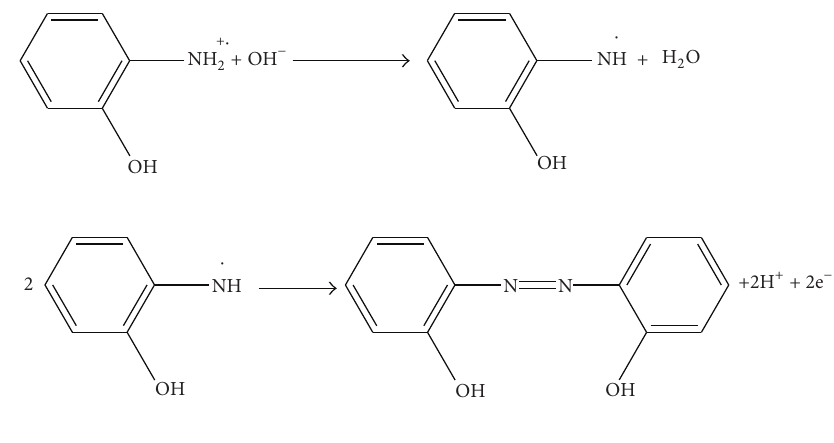
F 22: Formation of azo species from o -AP on the silver electrode in an alkaline medium